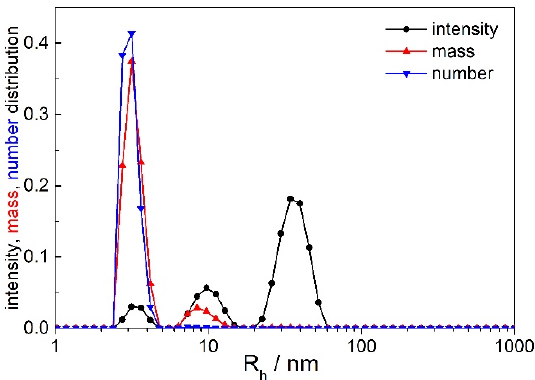
Figure 2. The intensity, mass, and number weighted distributions of particles in the plasma of ovarian cancer patient OC5: θ = 90°, T = 25 °C. The distributions were calculated by considering the viscosity of water ( η o = 0.9 mPa s − 1 ).